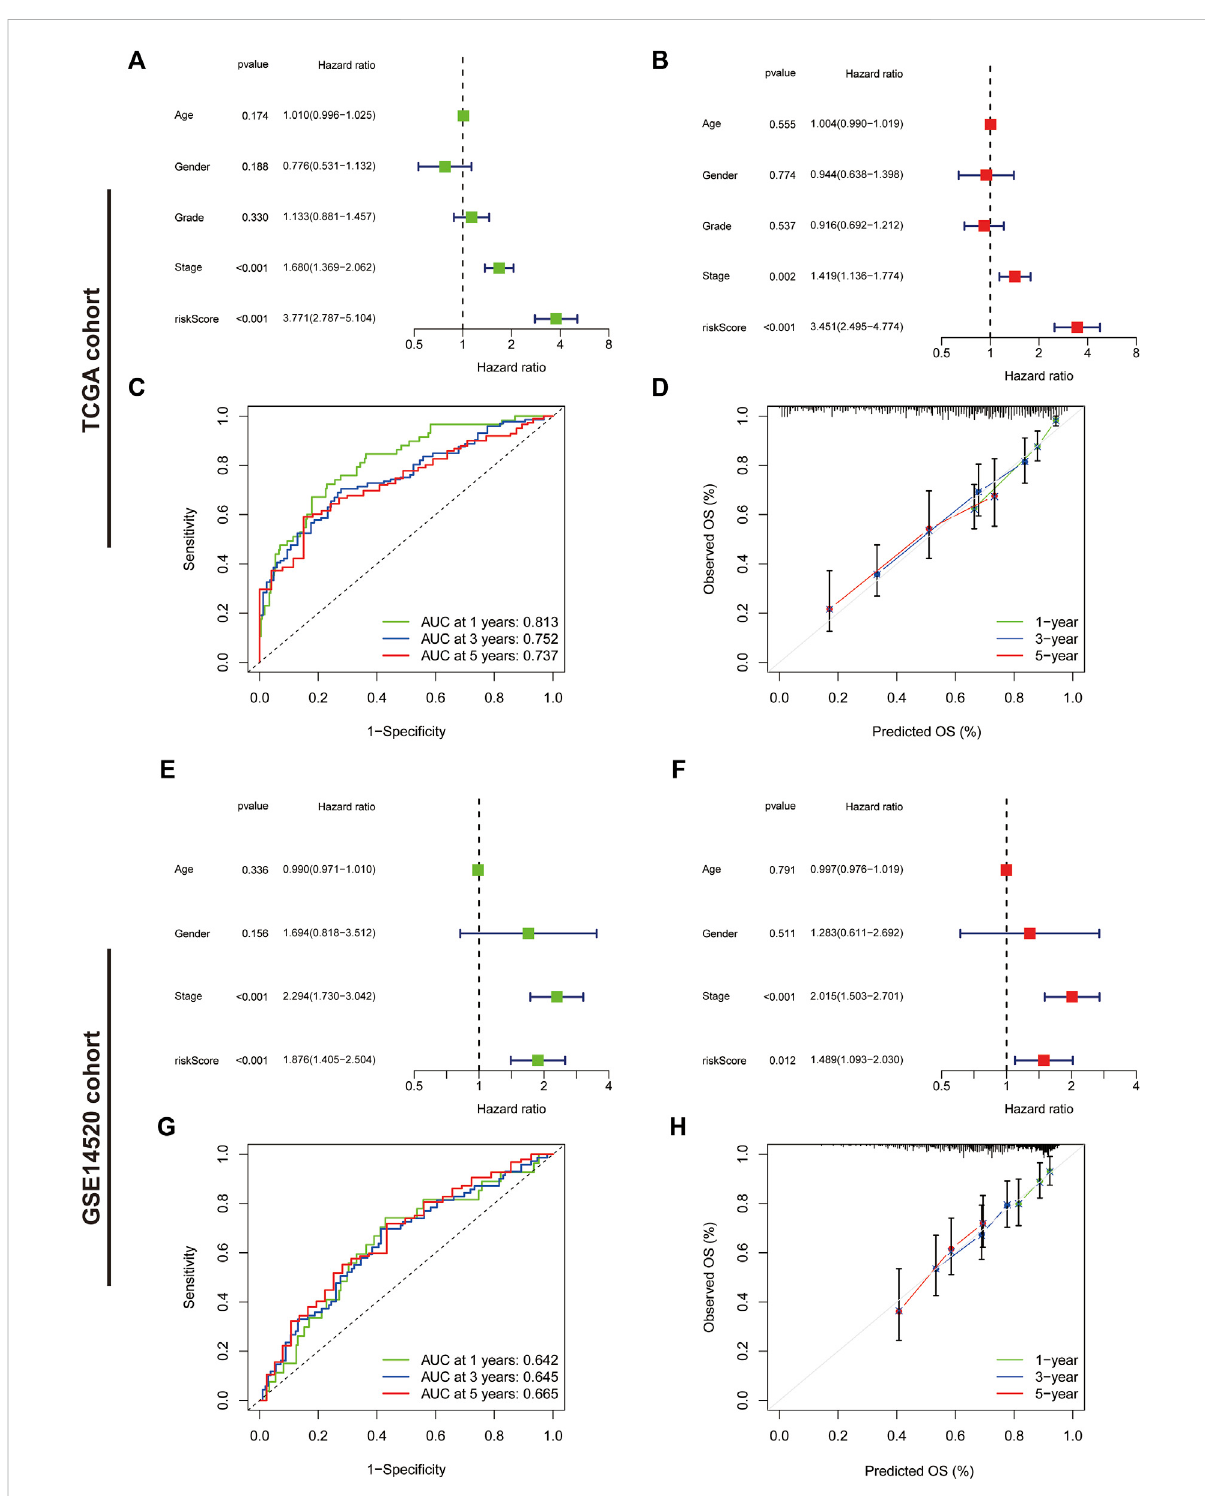
FIGURE 6 Assessment of the immune-related gene signature. (A) Forest plot for univariate Cox and (B) multivariate Cox regression analysis in The Cancer Genome Atlas (TCGA) cohort. (C) Receiver operating characteristic (ROC) curves of 1-, three- and 5-year survival for the predictive signature in the TCGA cohort. (D) The calibration curves for 1-, three- and 5-year OS in the TCGA cohort. (E) Forest plot for univariate Cox and (F) multivariate Cox regressionanalysis in thevalidation cohort. (G) ROC curves of1-, three- and 5-year survivalfor the predictivesignature inthevalidation cohort. (H) The calibration curves for 1-, three- and 5-year overall survival in the validation